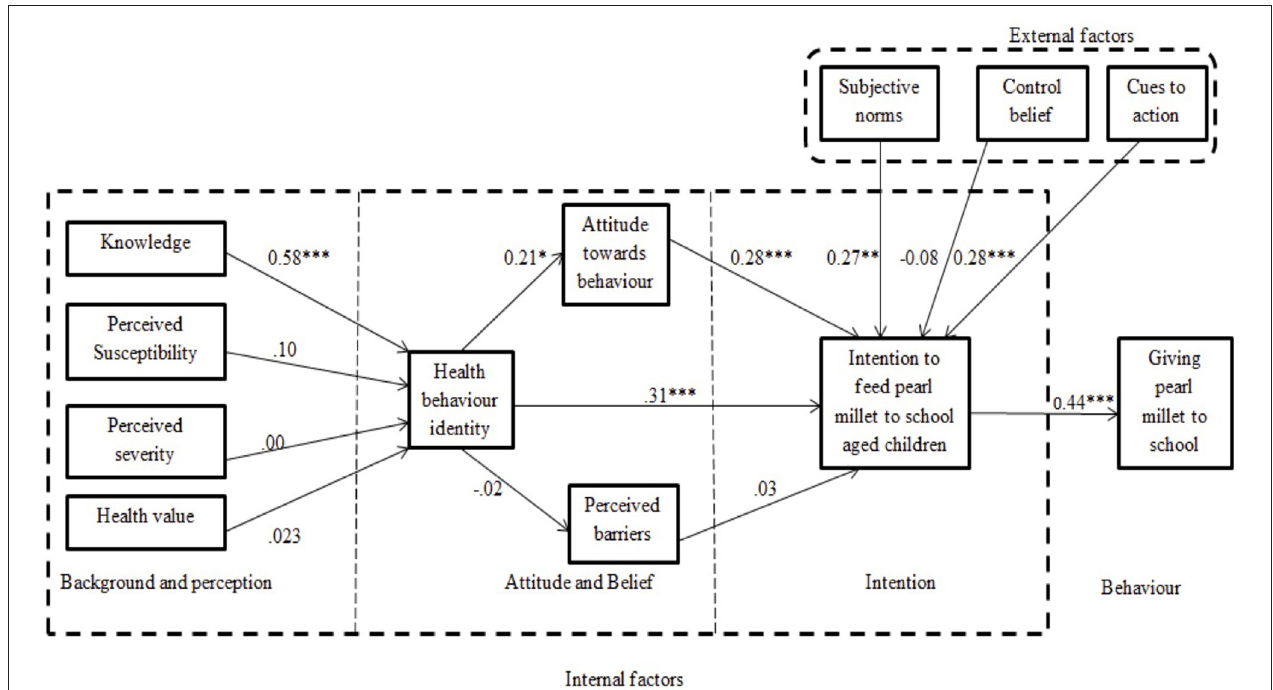
FIGURE 2 | A combined model of the theory of planned behavior and health belief model with Spearman correlation coefficients between related constructs ** P ≤ 0.01 and *** P ≤ 0.001 (2-tailed).